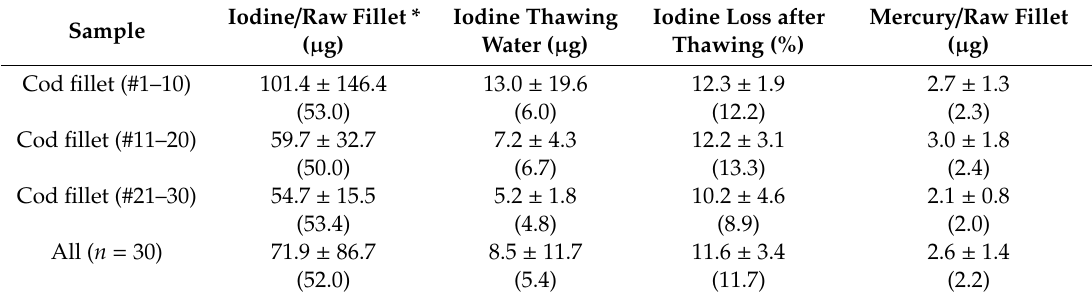
Table 1. Total iodine and mercury ( µ g) in raw cod fillets after thawing and iodine in thawing water ( µ g and %). Numbers are given as mean ± SD and (median) wet weight.